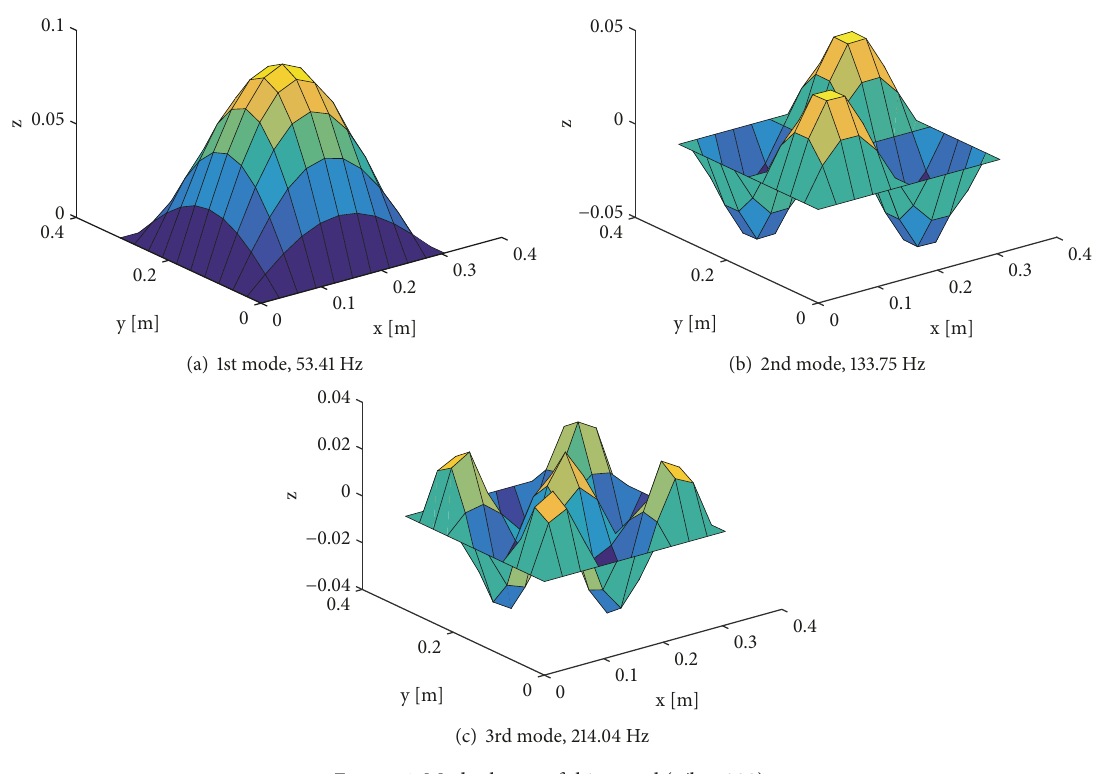
Figure 1: Mode shapes of thin panel (a/h = 300).